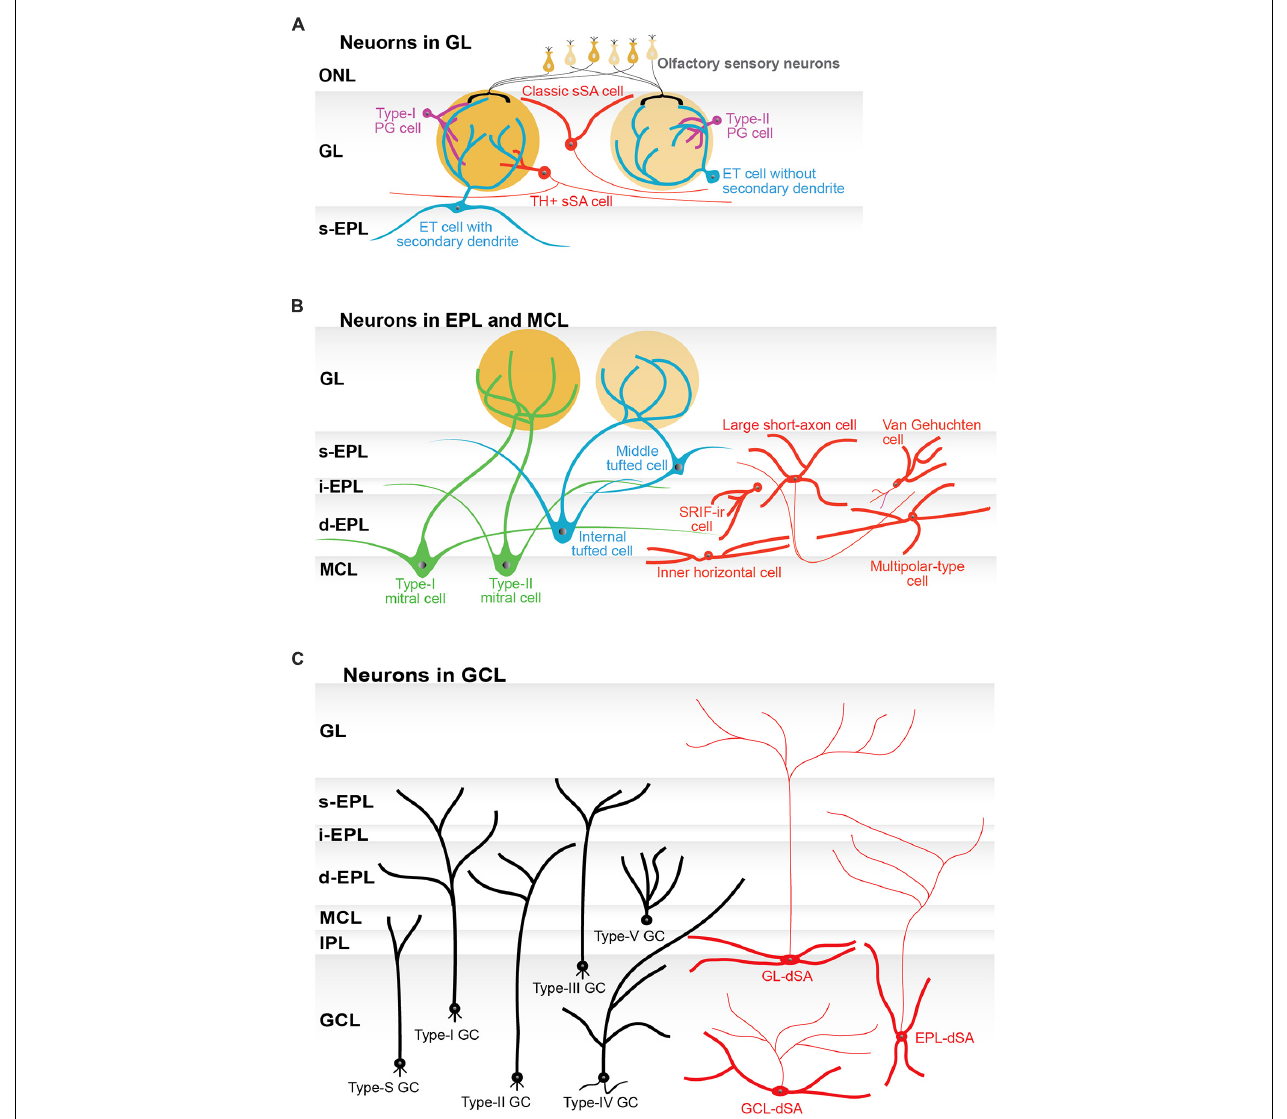
subtypes of mitral cells are based on the depth of their secondary (basal) dendrites in the EPL sub-layers and are referred to as type-I and type-II mitral cells, respectively. On average, middle tufted cells have smaller cell somata than internal tufted cells, and internal tufted cells have smaller cell somata than mitral cells. Among interneurons, only large short-axon cells have axons. Some of the neurons that had originally been categorized as short-axon cells have an axon-like process (see main text), but they are not shown in this figure to avoid any confusion.Van Gehuchten cells are axonless cells, while inner horizontal and multipolar-type cells are identified by their morphological features and locations.The majority of interneurons have been studied by parvalbumin (PV) labeling. In addition, somatostatin-immunoreactive (SRIF-ir) cells are located in the i-EPL/d-EPL and extend their dendrites specifically to the d-EPL. (C) Schematic illustration of six subtypes of granule cells (GC; black) and three subtypes of deep short-axon cells (dSA cells; red) in the granule cell layer (GCL).The subtypes of granule cells and dSA cells are determined based on the location (depth) of their cell somata in the GCL and the layer or sublayer to which their dendrites extend.These subtypes of GC are referred to as type-I, type-II, type-III, type-IV, type-V, and type-S cells.The subtypes of dSA cells are referred to as GL-dSA, EPL-dSA, and GCL-dSA cells, reflecting the distribution of their axons. Abbreviations: GL, glomerular layer, ONL, olfactory nerve layer; IPL, internal plexiform